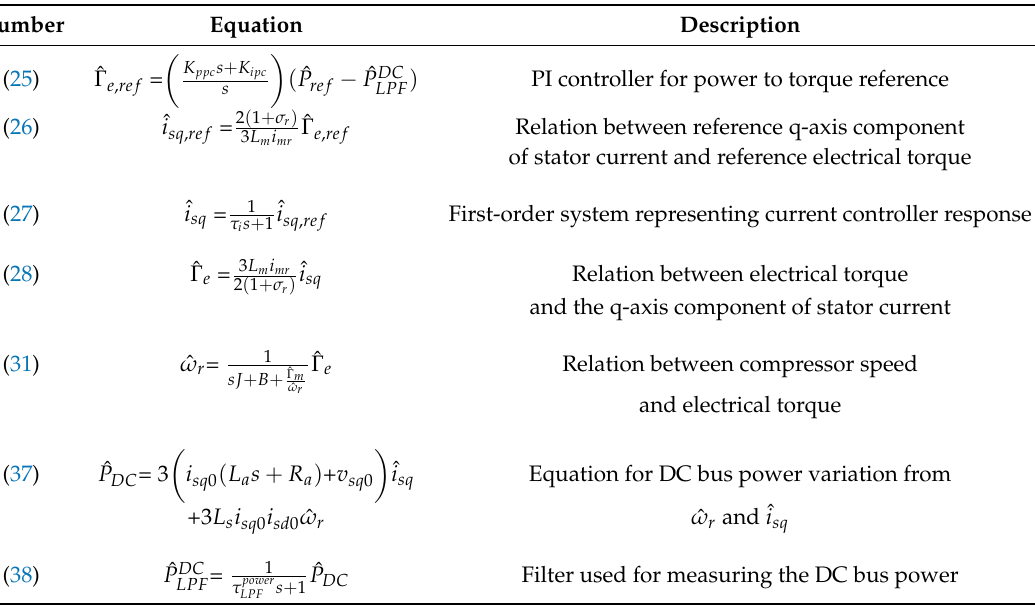
Figure 5. Block diagram for the small-signal frequency domain analysis of the VSHP. Table 2. Summary of the